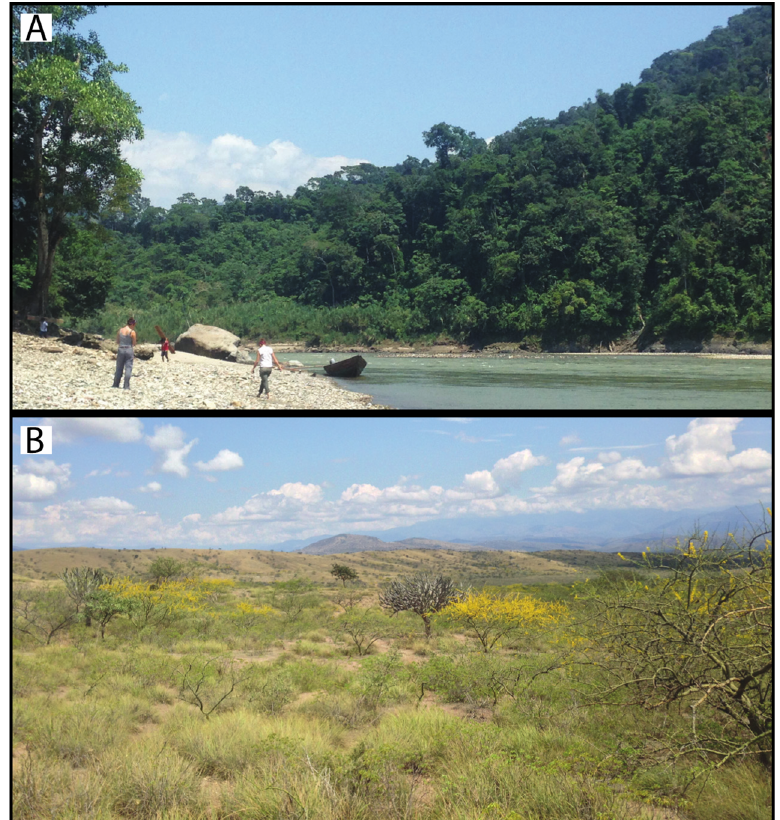
Figure 3. Photographs showing the contrasting landscape between ( A ) the eastern slope of the Eastern Cordillera and the ( B ) Bagua Basin at the same latitude.